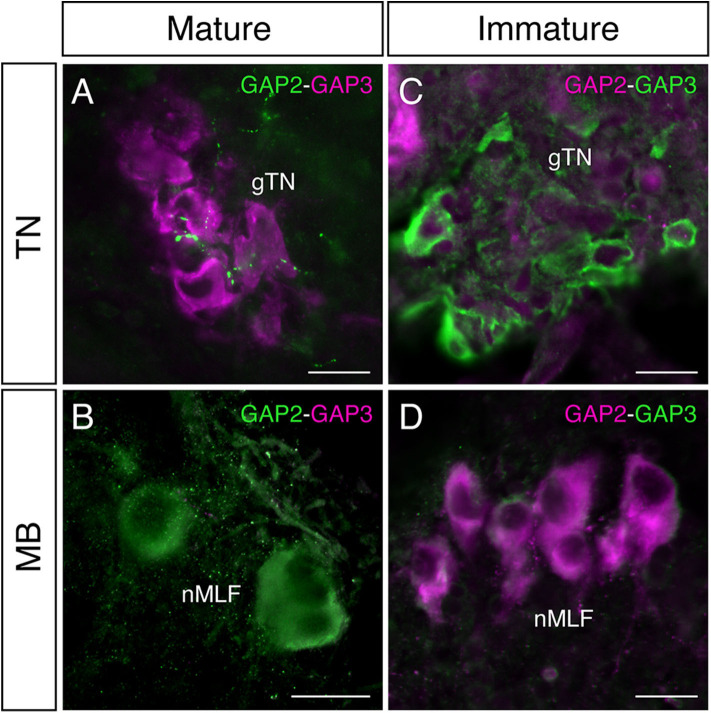
Photomicrographs of double immunofluorescence of GnRH-GAP2 and GnRH-GAP3 in the brain of sexually mature and immature male tilapia. In mature males, GnRH-GAP2-immunoreactive (ir) neuronal processes (green) are closely located to GnRH-GAP3-ir cell somata (magenta) in the terminal nerve ganglion (gTN, A), while such interaction between GnRH-GAP3-ir neuronal processes (magenta) and GnRH-GAP2-ir cell soma (green) was not seen in the nucleus of the medial longitudinal fascicle (nMLF) of the midbrain (MB, B). No proximities of GnRH-GAP2 (magenta) and GnRH-GAP3 (green) neuronal processes/cell somata were observed in immature males (C,D). Scale bars = 20 μm.